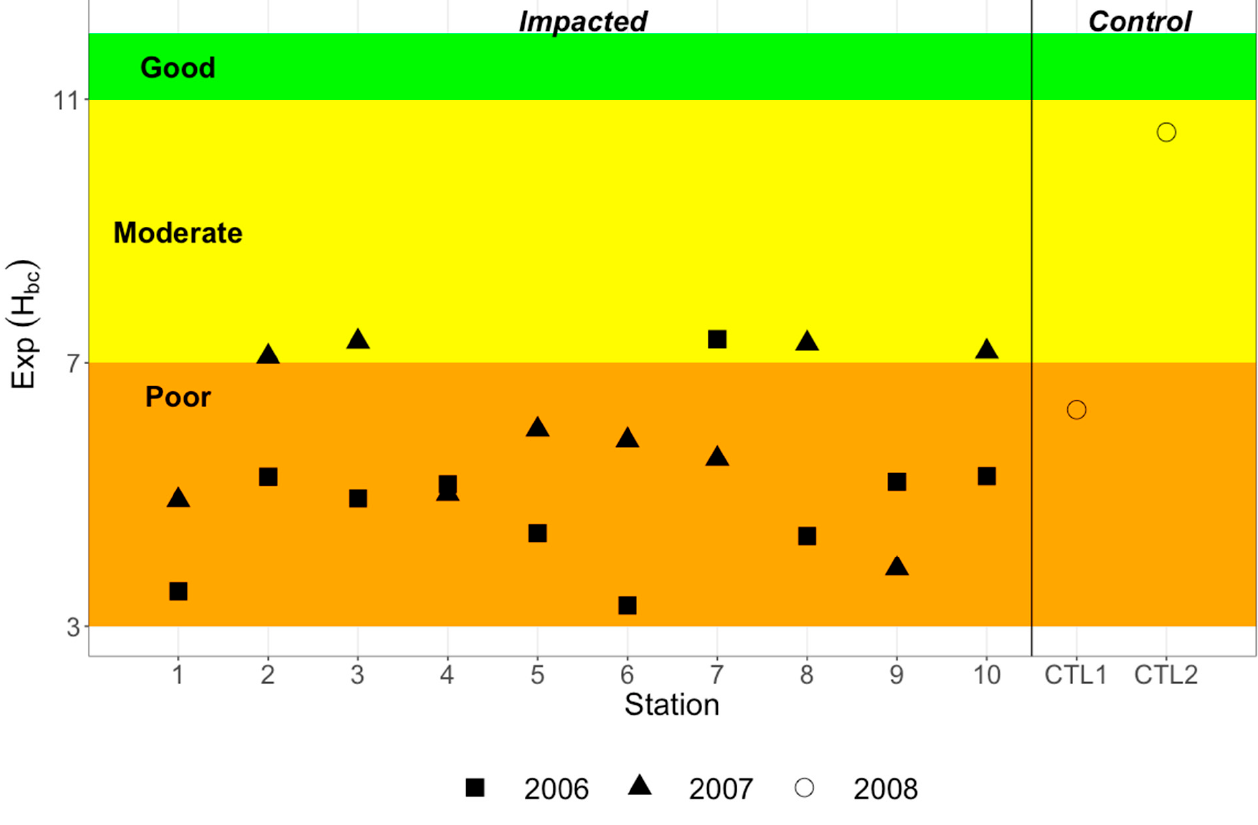
Figure 5. Ecological Quality Status (EcoQS) derived from exp(H’ bc ). The EcoQS was evaluated ac- cording to the criteria defined by Bouchet et al. [78].